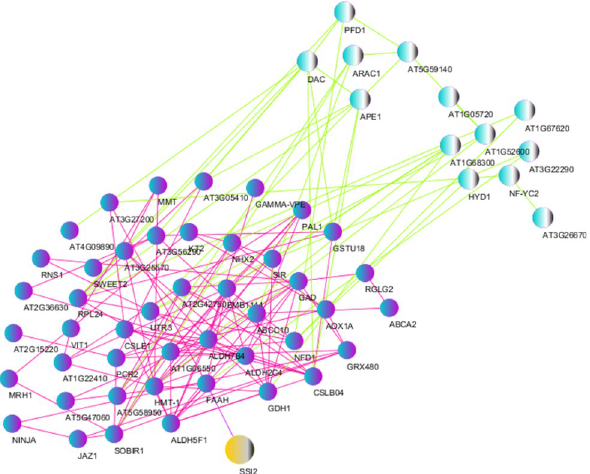
Fig 10. The protein-protein interaction network of common DEGs using STRING database and Cytoscape software. Interaction network of 61 common DEGs between hormonal and biotic datasets. The yellow colored nodes represent the key genes expressed in the pathways of resistance to the pathogens and signaling of hormones, and the pink colored nodes represent the genes with the most connectivity to major genes in the network.